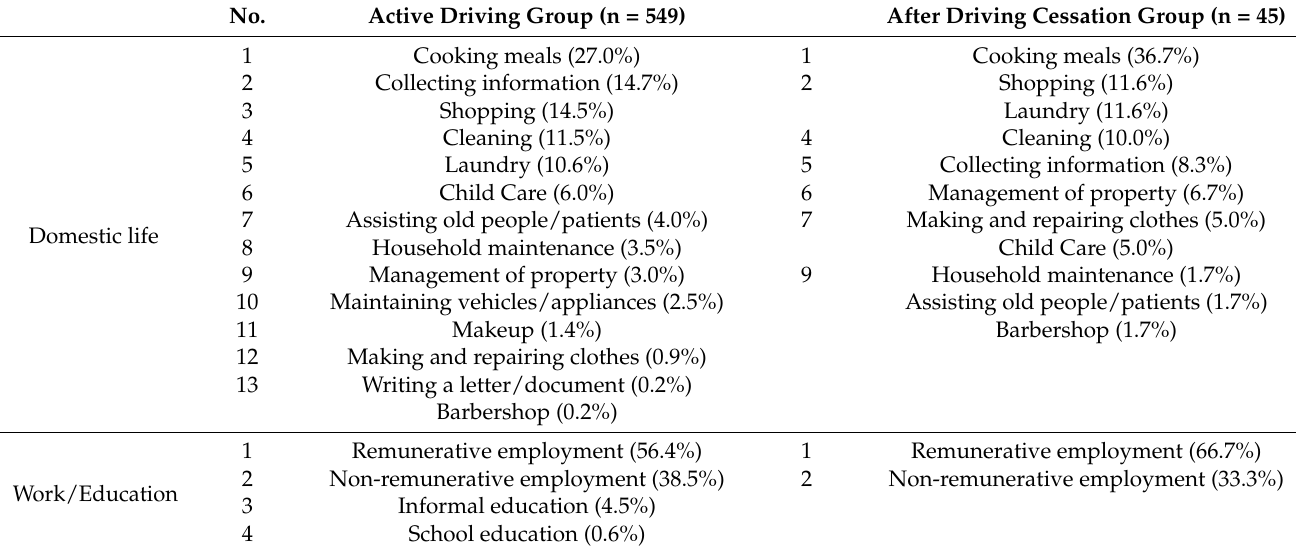
Table 2. Detail of meaningful activities related to domestic life and work/education in the active driving group and after driving cessation